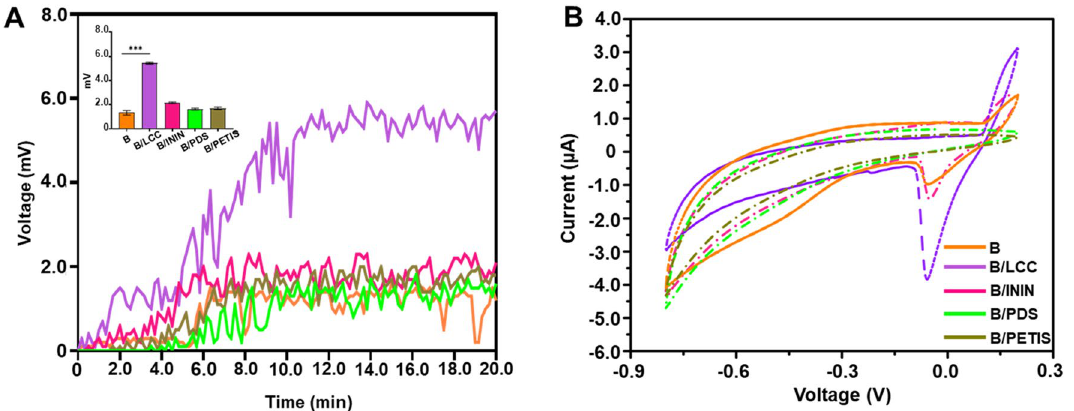
Figure 2. Electricity production by LCC fermentation of S. epidermidis. ( A ) The electricity measured by voltage changes (mV) was recorded for 20 min after pipetting S. epidermidis alone or with LCC (B/LCC), ININ (B/ ININ), PDS (B/PDS) or PETIS (B/PETIS) on the surface of an anode. ( B ) Cyclic voltammetry was employed to measure the current (µA) generated by various experimental conditions above. Data presented the mean ± SD from three separate experiments. *** P < 0.001 (two-tailed